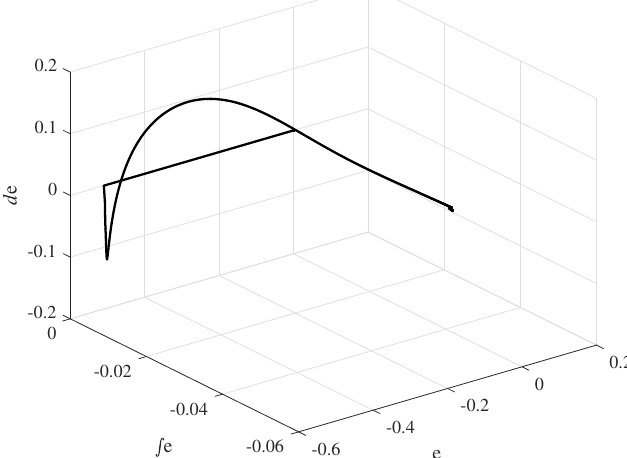
(cid:82) e -˙ e under target speed tracking.